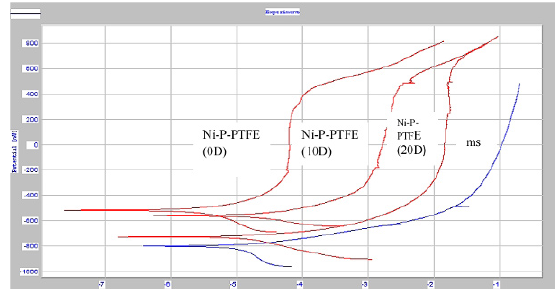
Figure 7. Anodic Polarization for mild steel (ms) and Ni-P-PTFE coating after different exposure times in 3.5% solution of NaCl: zero days (0D), ten days (10D), and twenty